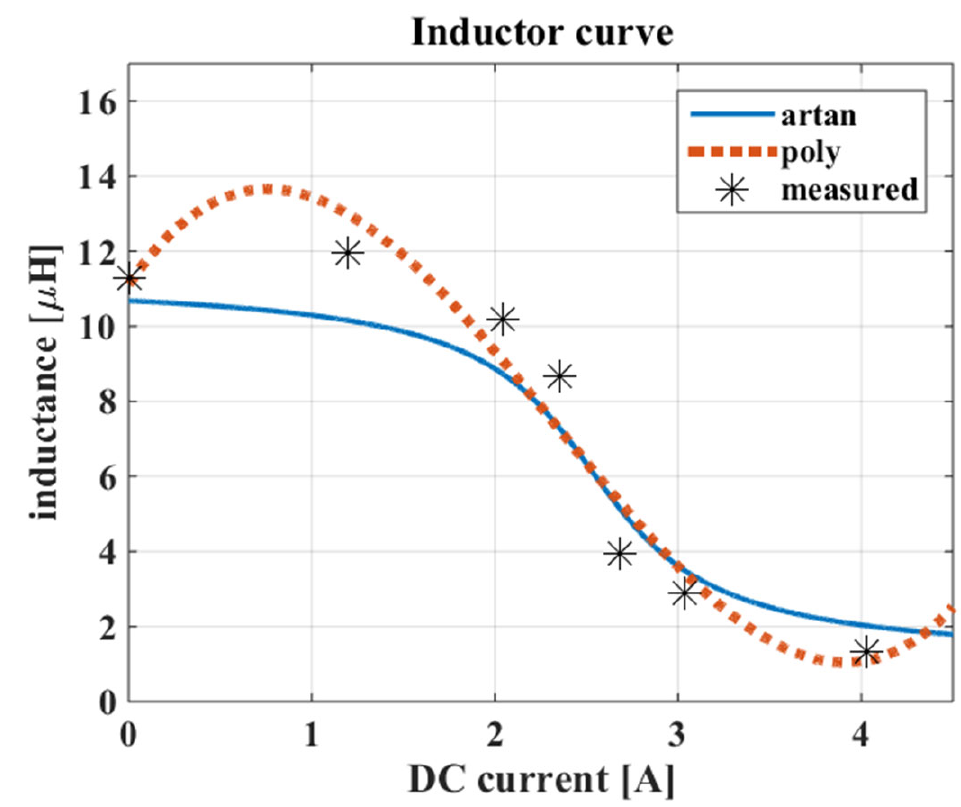
Figure 7. Characteristic curve of the non-linear inductor obtained by the arctan and polynomial model. The obtained curves show that the polynomial curve can model the initial part in which a slight increase is present; however, it cannot be used approaching deep satura- tion since it shows an increase in the inductance. The arctan model approximates the values corresponding to deep saturation for higher current; however, the decreasing value asymptotically follows the deep saturation value. Both models can cover the whole range of operation, meaning from a small current up to saturation. This last consideration im- proves what was stated by [26], which showed the polynomial approximation validity for a reduced range of